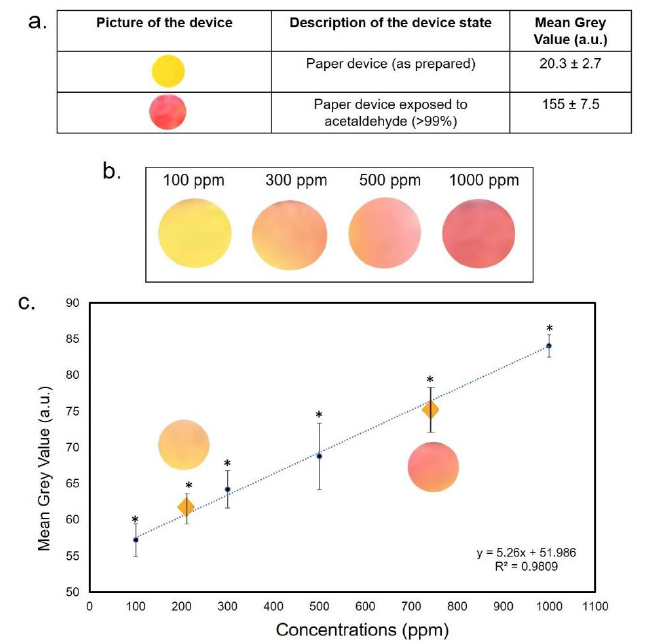
Figure 6. ( a ) MGV values of PAD as-prepared and after the exposure to pure C 2 H 4 O (>99%). ( b ) color change after C 2 H 4 O exposure. ( c ) Interpolation of C 2 H 4 O intermediate values (200 and 750 ppm).